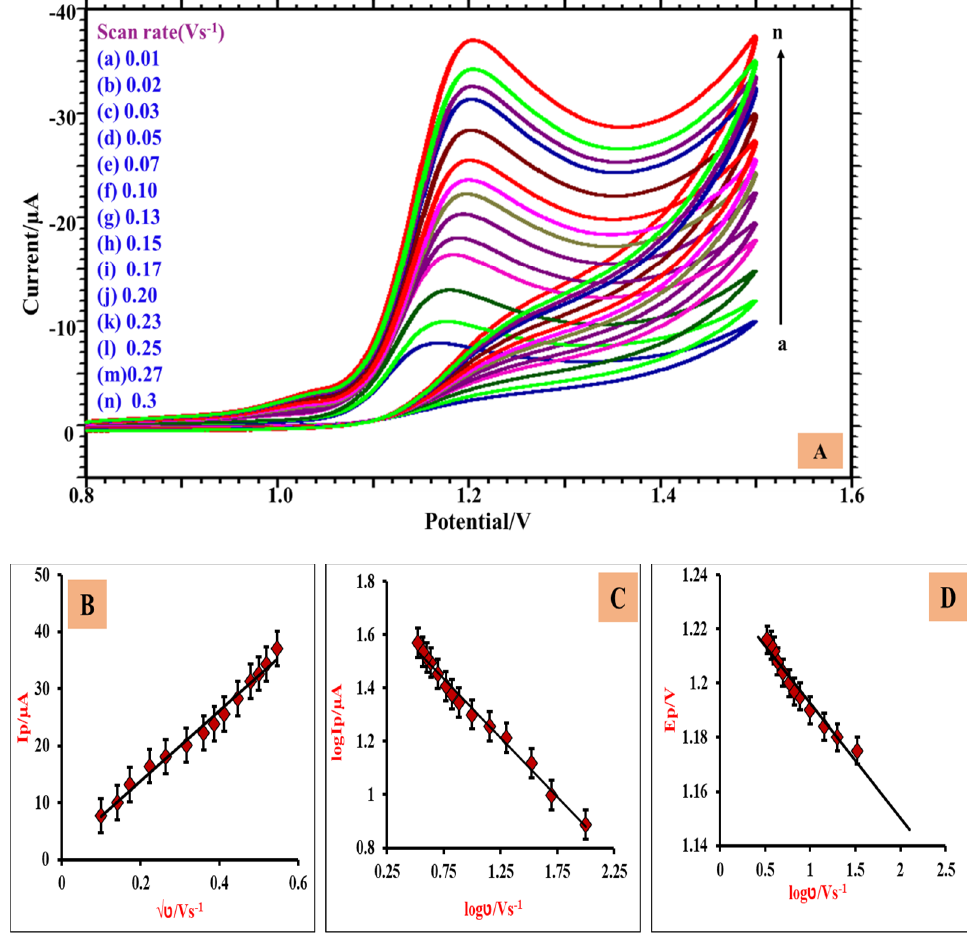
Figure 5. ( A ) Cyclic voltammograms of the THP (0.1 mM) in different electrolytic solutions in the CuO-GO/CPE; t acc = 10 s; scan rate = 0.05 Vs −1 . ( B ) Plot of E pa vs. pH. ( C ) Change in peak current with the